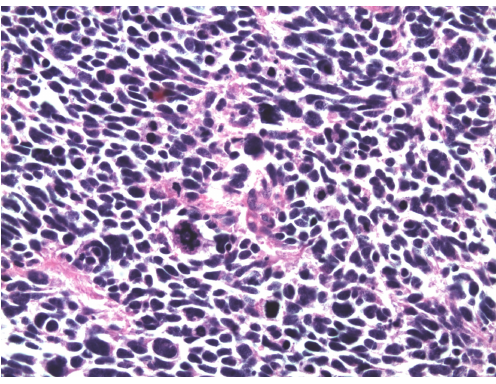
Figure 2: Grossly, the intramural tumor mass occupies over 95% of the gallbladder wall and protrudes into the lumen. The tumor mass has a solid tan-red colored fleshy cut surface.